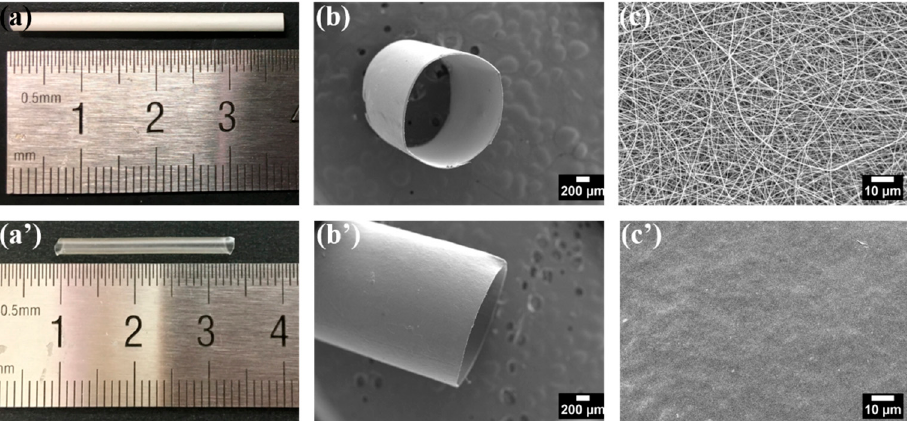
Figure 5. The gross appearance and SEM images of electrospun collagen tube before (previous row) and after (next row) immersing in water for 15 min. The gross appearance ( a,a’ ), SEM images of collagen tube: entire ( b,b’ ) and surface ( c,c’ ).